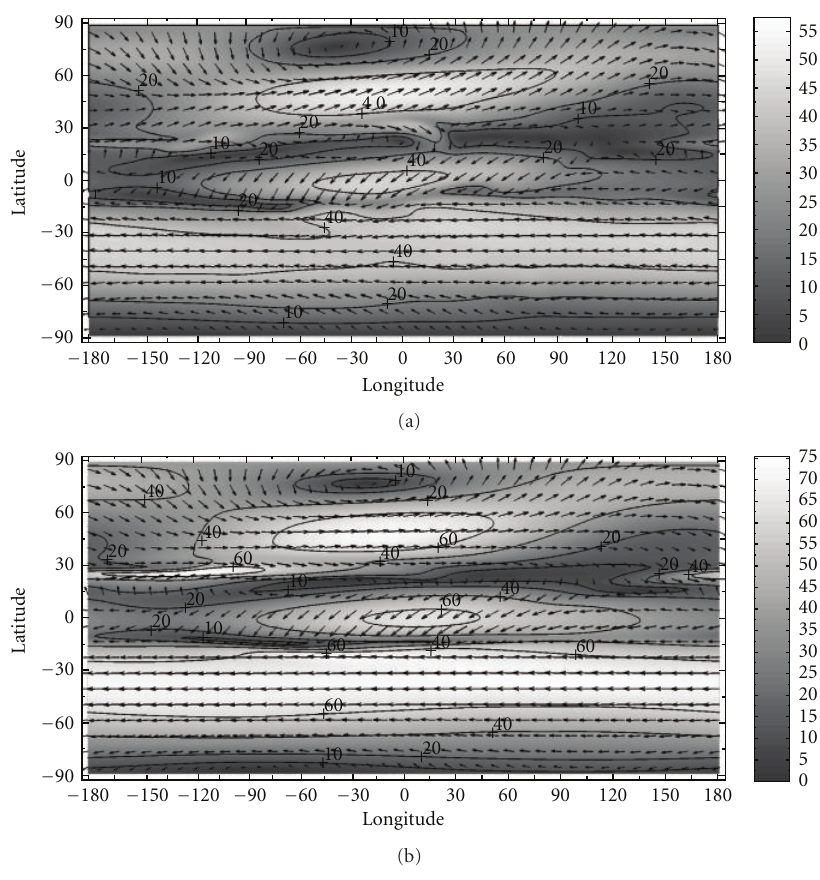
Figure 4: The same as in Figure 3 but at the altitude of